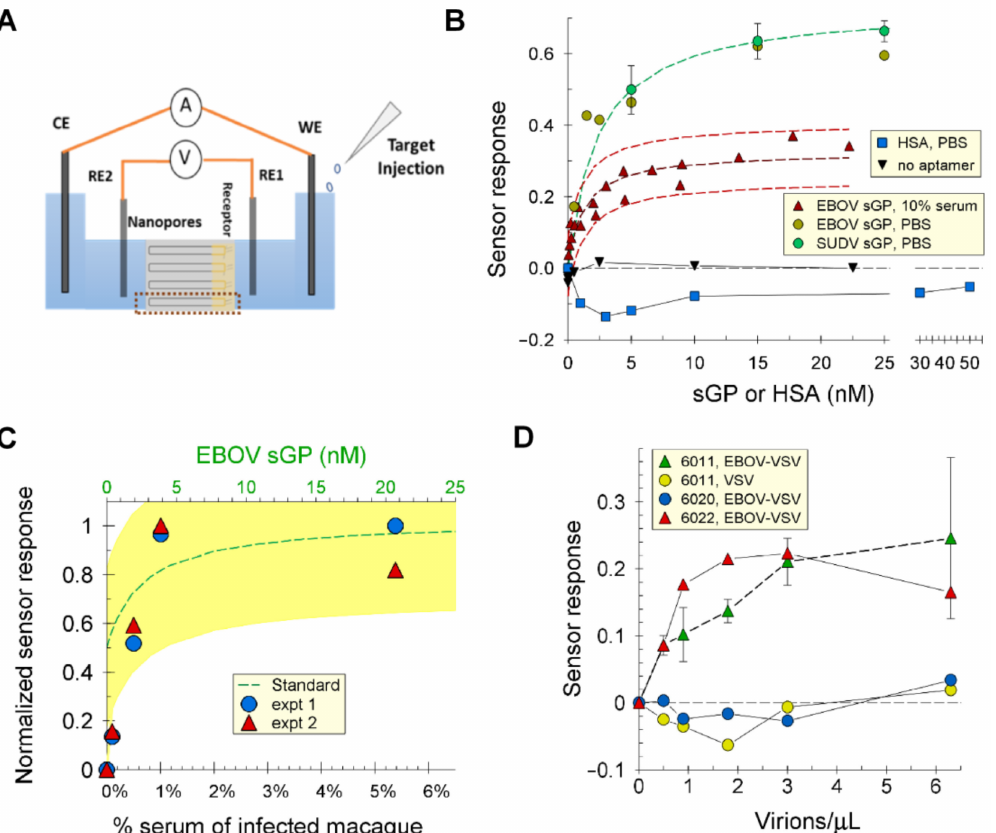
Figure 7. Electrochemical sensing . ( A ) Sensing cell setup. ( B ) When mounted on an NAAO membrane, oligonucleotide 6011 produced an electrochemical signal in response to EBOV sGP in the presence of 10% human serum (red triangles) and in its absence (gold circles). It also responded to SUDV sGP (green circles) with the same binding isotherm as for EBOV sGP. The aptasensor did not respond to the addition of HSA (blue squares). There was no electrochemical response from the NAAO membrane lacking the aptamer (inverted triangles). The figure shows the results of single titrations for no aptamer, has, and EBOV sGP in PBS; an average of duplicate independent titrations for SUDV sGP; and a compiled set of data from 3 independent titrations for EBOV sGP in 10% human serum. Fit lines are shown for SUDV sGP in PBS (dashed green) and EBOV sGP in 10% serum (dashed dark red) with red dashed lines above and below the fitline to show the range of average deviation ( ± 5%) from the fit for EBOV sGP in 10% serum. ( C ) The NAAO sensor conjugated with oligonucleotide 6011 was used to titrate infected macaque serum in a background of 10% macaque serum. The results of two experiments are shown. A standard curve with recombinant sGP in 10% uninfected macaque serum (green dashed line) was used to determine a concentration of 1 to 1.3 µ M in the infected serum. The yellow highlighted region identifies the 95% confidence level for the standard curve. ( D ) EBOV pseudotyped virions (EBOV-VSV) or VSV without glycoprotein (VSV) in PBS were titrated in the electrochemical sensor functionalized with 5 (cid:48) thio-oligonucleotides, 6011, 6020, and 6022. The results show the average of 2 independent experiments for 6011 with EBOV-VSV, 3 independent experiments for 6011 with VSV, and 1 experiment each for 6020 and 6022. Shown are the average values with the standard deviations. The concentrations of sGP are based on the dimer molecular weight. The density of virions was determined by dynamic light scattering. The sensor response (S) was calculated as S = ∆ R/R, and the normalized sensor response was S/S max . Nyquist plots for these data can be found in Figure